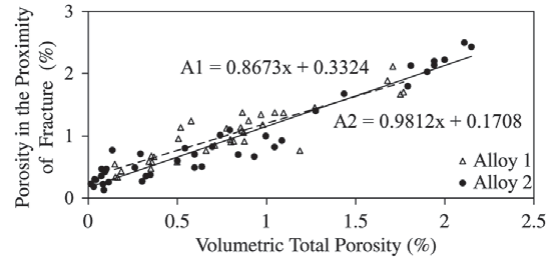
Figure 10. Correlation between global volumetric porosity and volumetric porosity in the